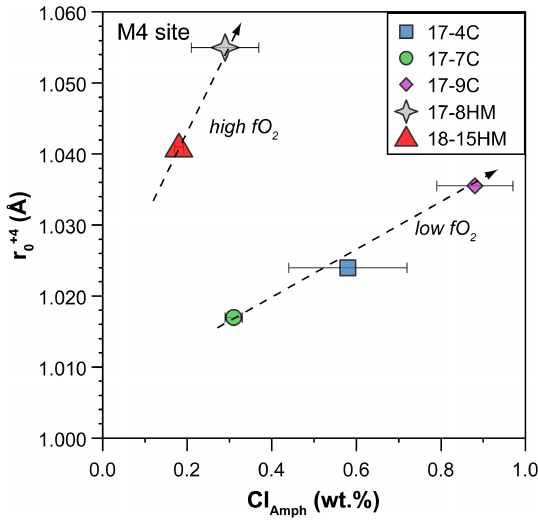
Figure 12. Relationship between Cl content in amphibole (in wt%) and the ideal radius ( r 0 in Å) of the M (4) site for + 4 cations as calculated by using the measured partition coefficients of U and Th and fitted solution to the strain-lattice model of Blundy and Wood (1994). Increase in r 0 of the M (4) site due to Cl enrichment in am- phibole allows Th 4 + ( r Th = 1.05Å) to be more compatible than U 4 + ( r U = 1.00Å). Data are reported in Table S3 of the Supple- ment, and the complete Onuma diagrams of the M (4) site are illus- trated in Fig. S3 of the